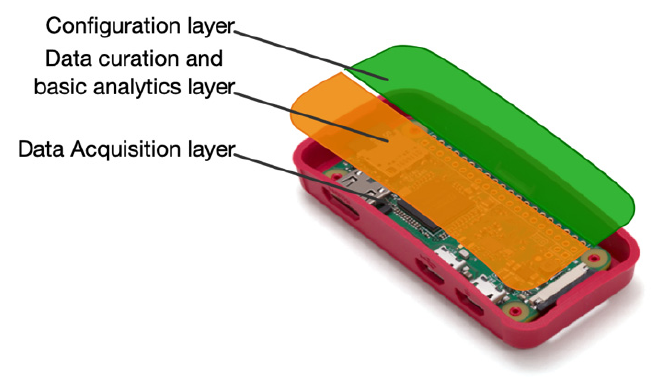
Figure 3. Operation layers of the Wi-Fi sensors at the device domain.